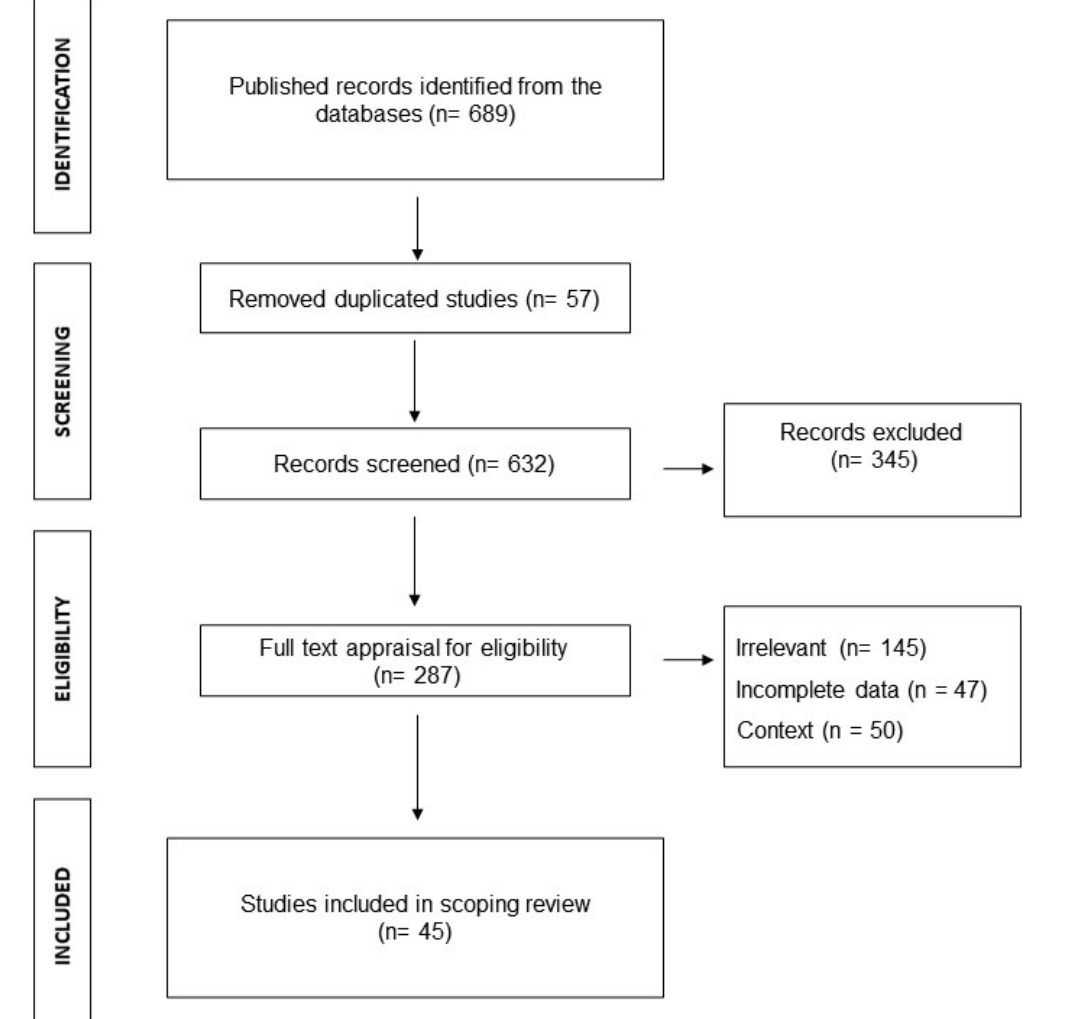
Figure 1. PRISMA flowchart shows the study design